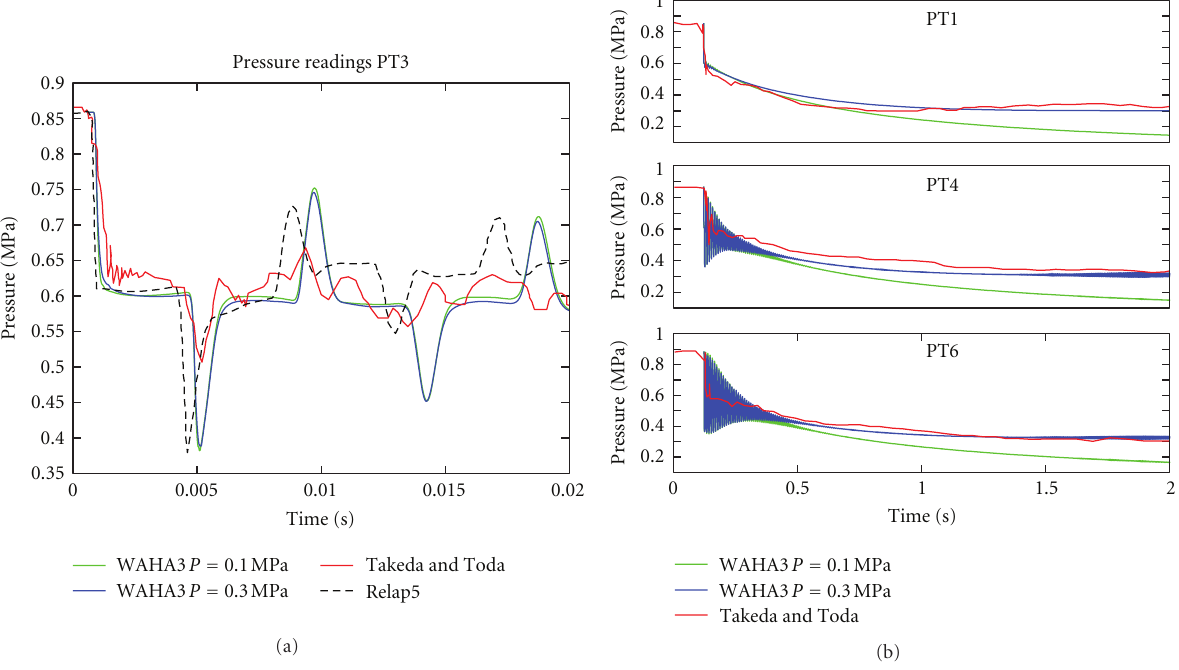
Figure 10: (a) Influence of tank pressure to the simulated results and comparison with experiment and RELAP5. (b) time 2s transient with di ff erent tank